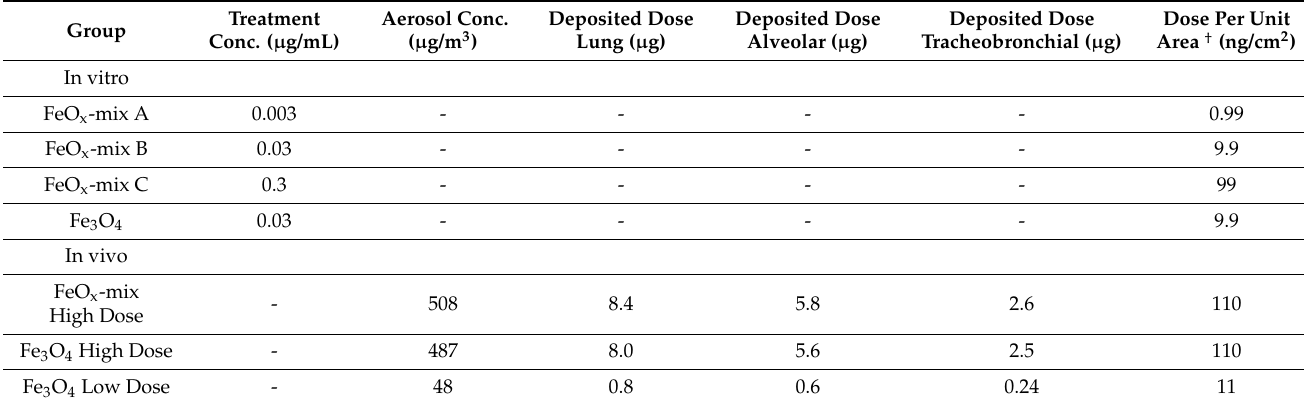
Table 3. Deposited doses for in vivo study compared with in